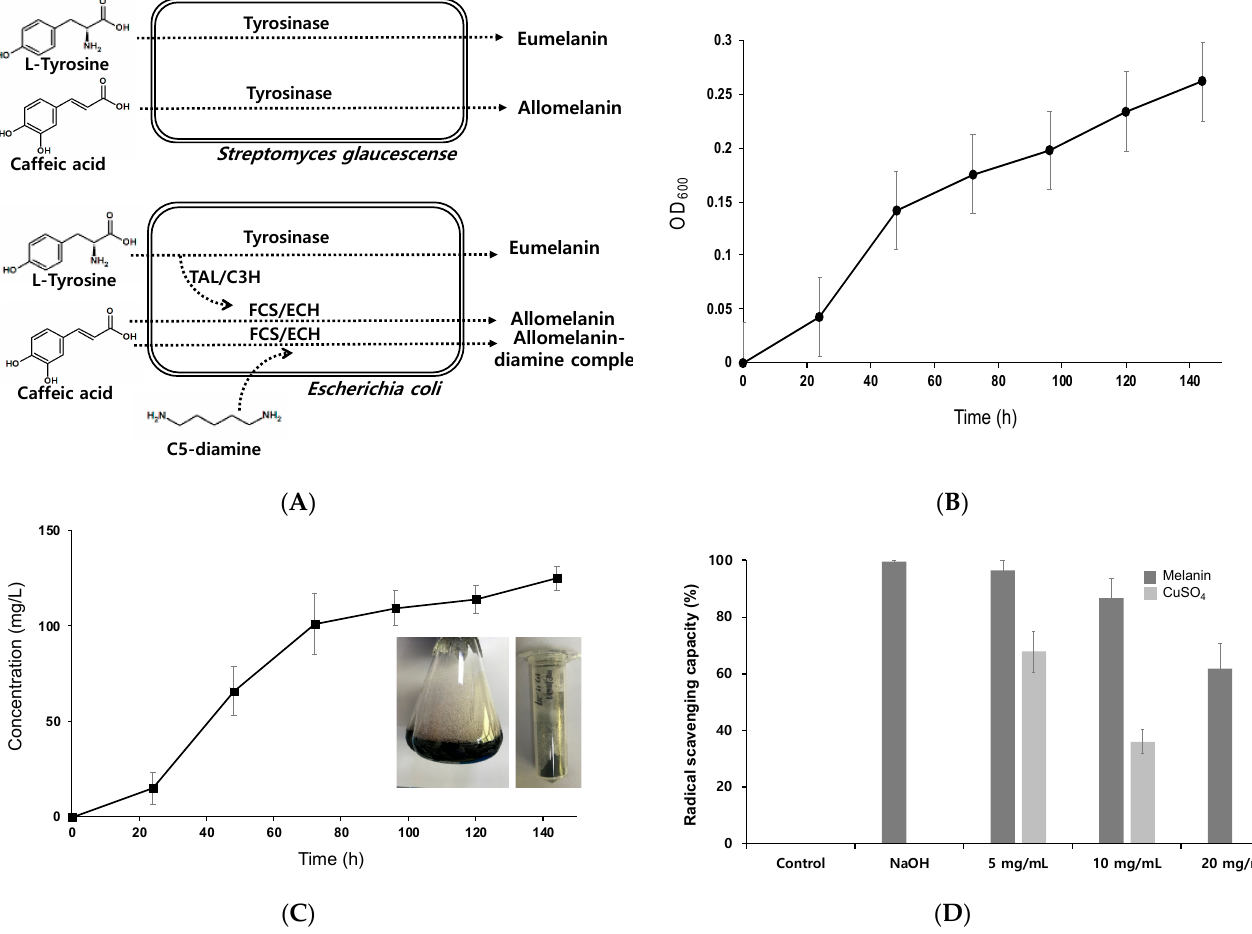
Figure 1. (A) Microbial conversion of L-tyrosine and caffeic acid by Streptomyces glaucescens and engineered E. coli . To prepare the microbial melanin pigments, 5 mM of caffeic acid was supplied to the culture medium and the isolated melanin pigment was dried for further experiments. (B) Time-dependent growth curve of S. glaucescens . (C) Time-dependent production of caffeic acid-based melanin. The highest melanin production titer was achieved at 125.25 ± 6.01 mg/L at 144 h of incubation. (D) Determination of radical scavenging capacity of melanin.